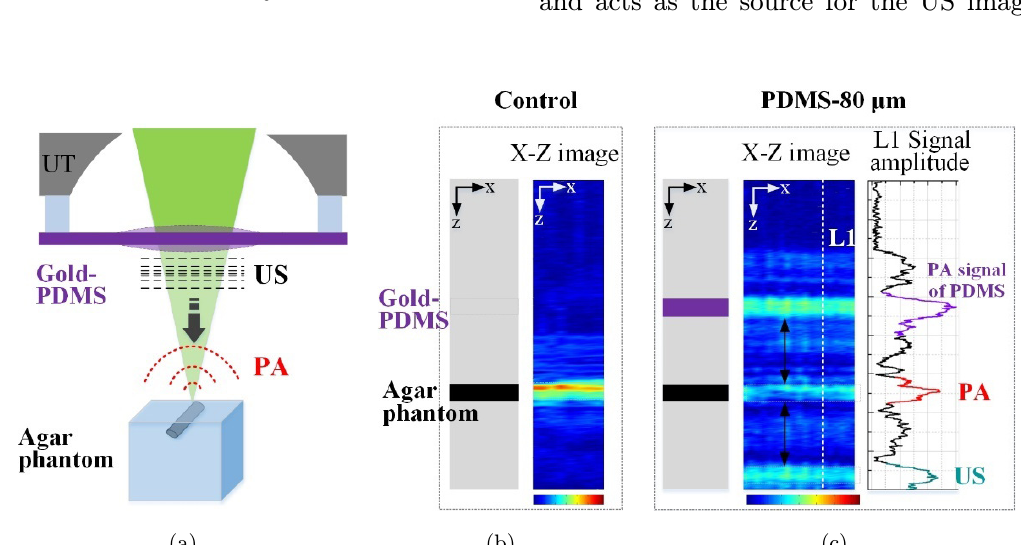
Fig. 5. Simultaneous PA and US imaging of an agar phantom. Figure 5(a) shows the sketch map of the phantom sample. (b) PA imaging of an agar phantom in x – z plane without gold-PDMS ¯lm. (c) Simultaneous PA and US imaging of an agar phantom in x – z plane with an 80 (cid:1) m gold-PDMS ¯lm, and the PA and US signal amplitudes along the white